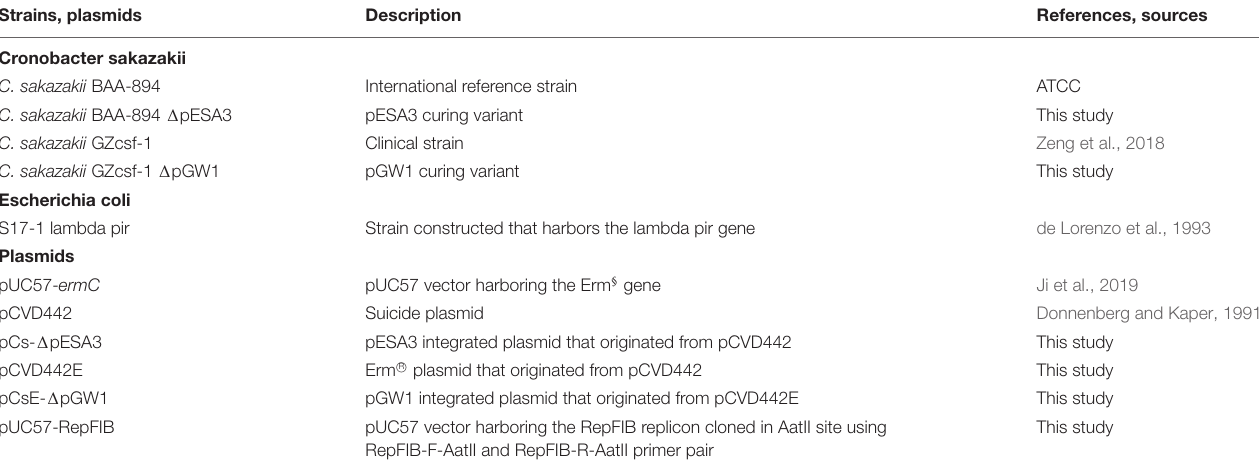
TABLE 2 | Bacterial strains and plasmids used in this study. Strains, plasmids